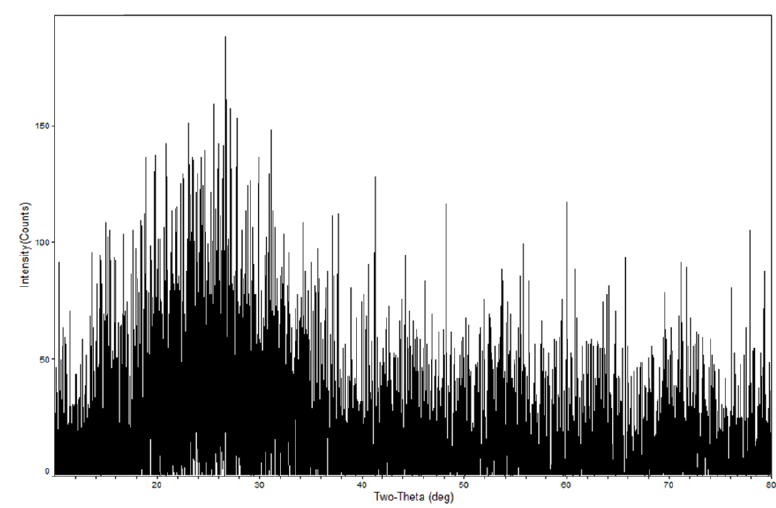
Figure 2. XRD results of glass.